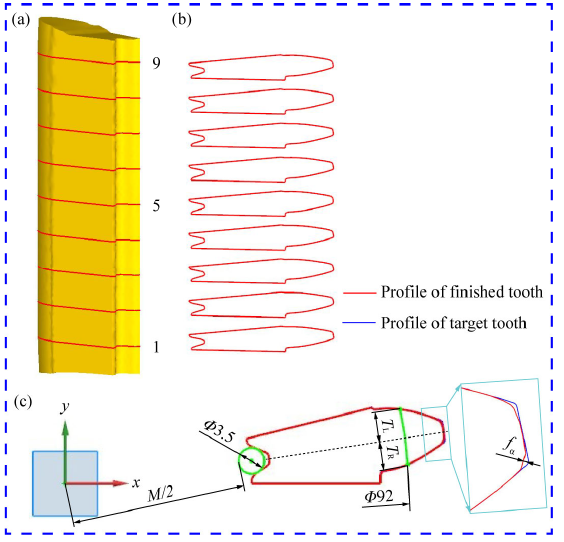
Figure 5. Prediction approach of tooth deviations: ( a ) Finished teeth; ( b ) extracted tooth profiles; and ( c ) measurment view.